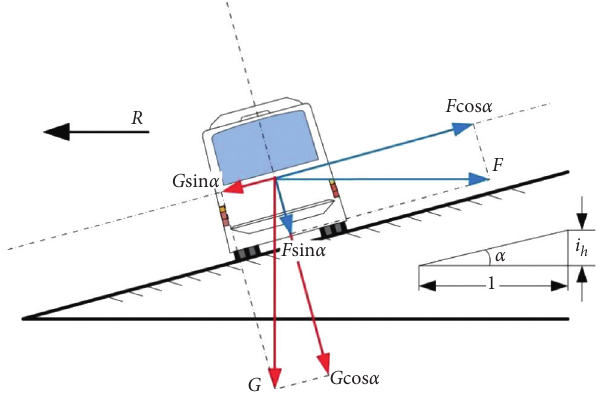
Figure 1: The dynamic mechanical balance of the vehicle on the curve.